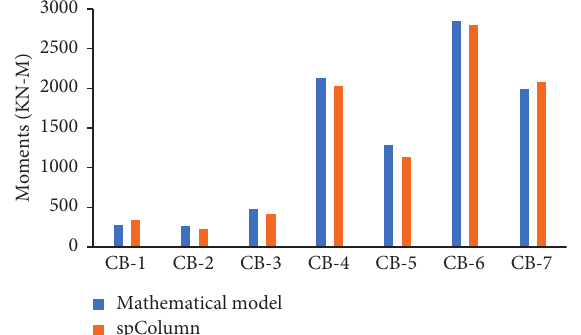
Figure 13: Axial load capacity comparison for biaxial columns